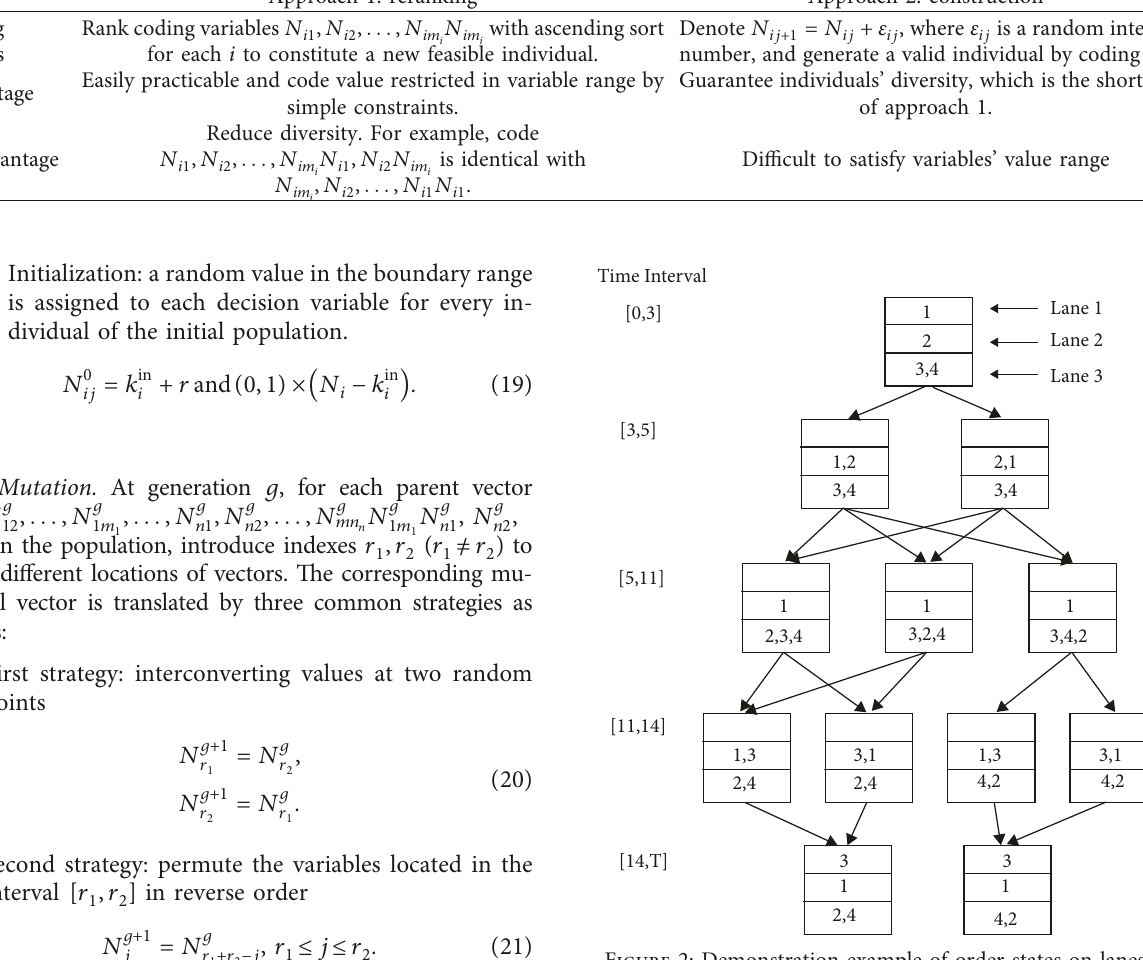
Table 2: Reranking and construction coding methods. Approach 1: reranking